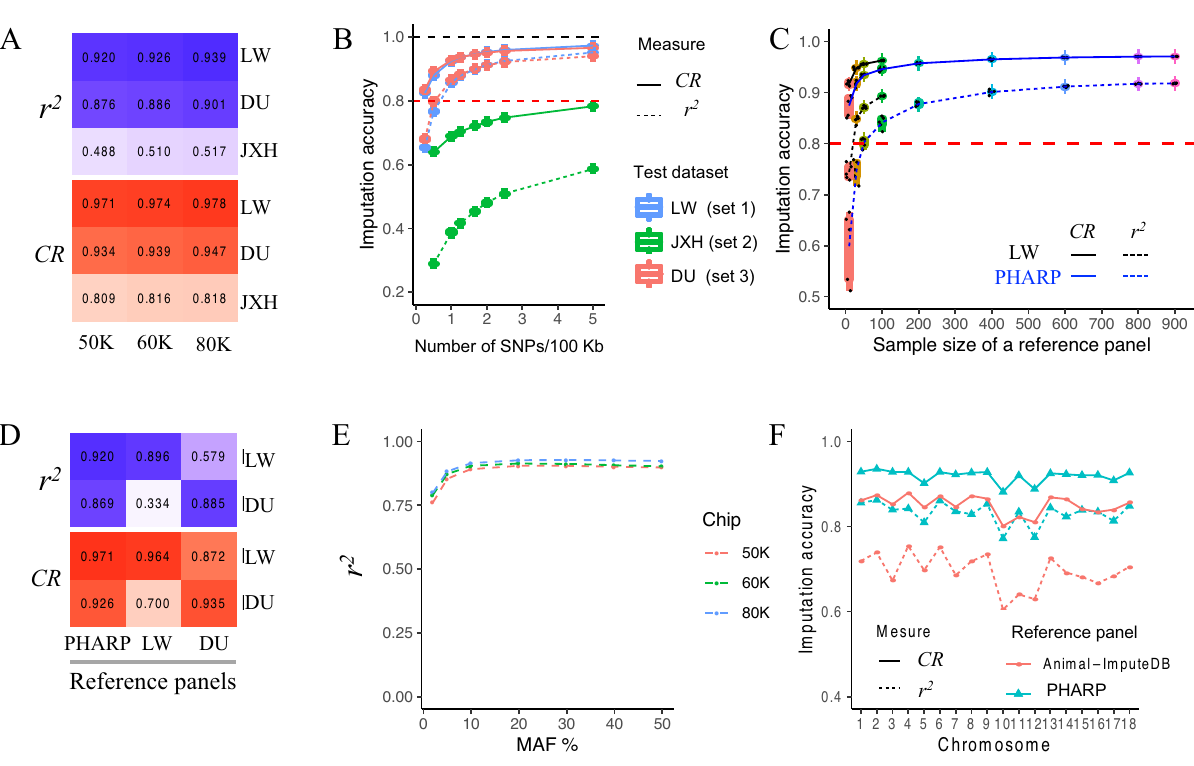
Figure 2. Imputation accuracy under different scenarios. ( A ) Mimicing three popular pig commercial chips (50 K, 60 K, and 80 K) using three datasets by masking all variants (only autosomes were used) except those on the chips; the held-out genotypes were considered as ‘real’ to calculate the CR and r 2 values. ( B ) Boxplot of imputation accuracy estimated by mimicking the imputed panel with different densities of SNPs on chromosome 1 using test datasets 1, 2 and 3 (see Supplementary Fig. S2 for plots of the remaining autosomes). ( C ) Boxplot of the imputation accuracy estimated by mimicking 50 K chip genotypes from dataset 1 using different sizes of reference panels constructed by randomly extracting samples from 1006 individuals or 115 Large White pigs (repeated 5 times, the different sizes of reference panel were marked with different colors). ( D ) Mimicking the 50 K chip genotypes from dataset 1 and 3 and using reference panels constructed by extracting samples according to pig breed (LW, Large White, n = 114; DU, Duroc, n = 85). ( E ) The imputation accuracies of the different MAF bins ((0, 0.02], (0.02, 0.05], (0.05, 0.1], (0.1, 0.2], (0.2, 0.3], (0.4 0.5]) estimated by mimicking the 50 K chip genotypes using dataset 1. ( F ) The imputation accuracy estimated from dataset 4 using our reference panel and that from Animal-ImputeDB. Dataset 1, Large White pig breed, LW, n = 81; dataset 2, Jiaxinghei pig breed, JXH, n = 54; dataset 3, Duroc pig breed, DU, n = 299; dataset 4, Duroc pig breed, n = 20, pigs were genotyped by both a 50 K chip and